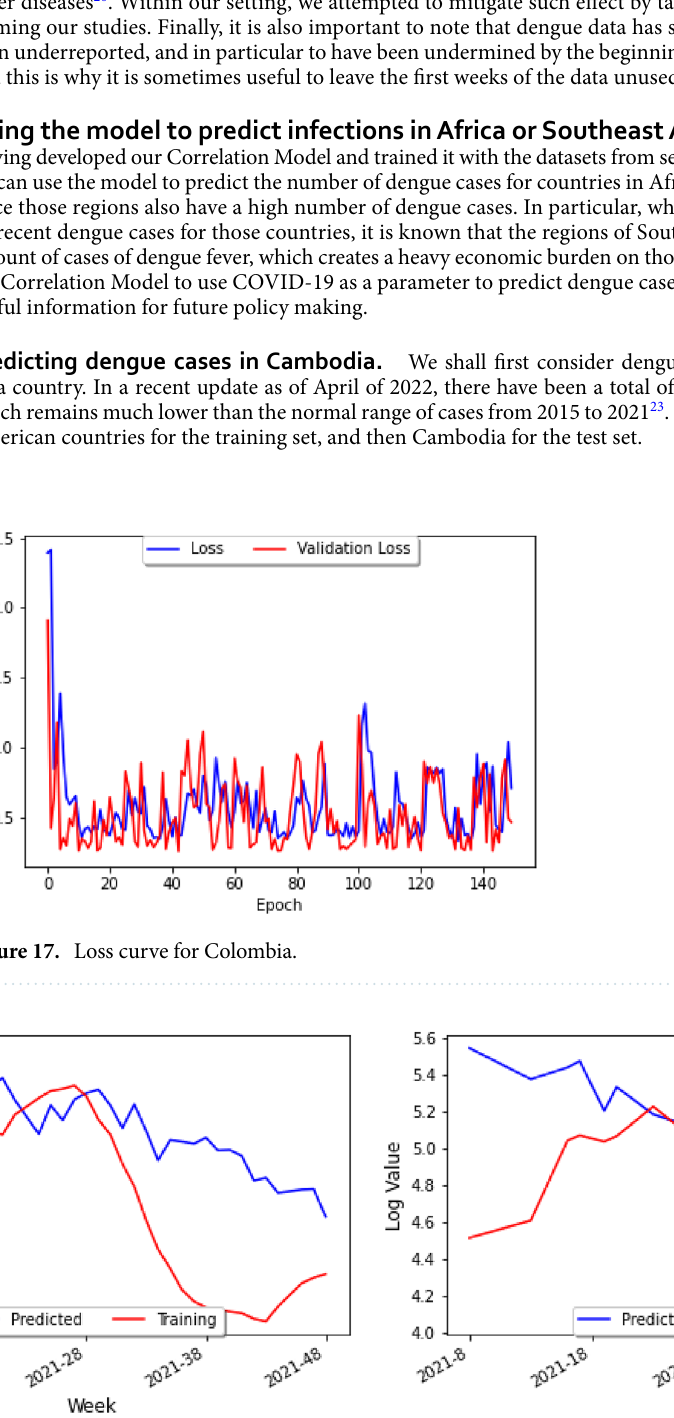
Figure 18. A graph of the actual data and the predicted data for Colombia, for when both holiday and climate factors are considered on the training set (left) and the test set